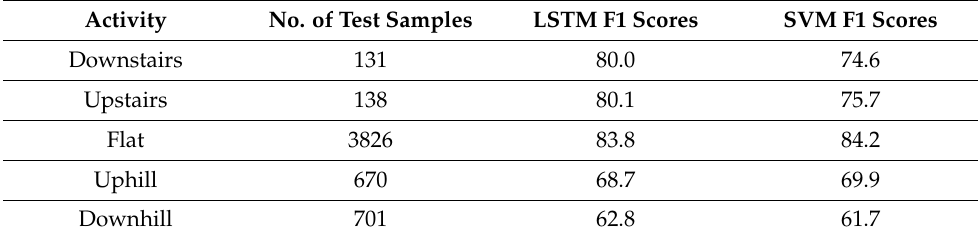
Table 7. Mean F1 Scores for Level 1 Label Resolution.